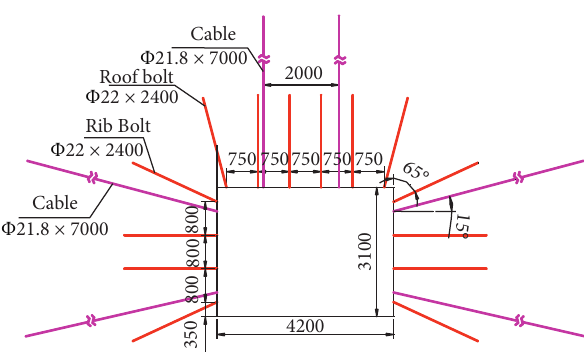
Figure 14: Schematic diagram of optimization scheme (unit: mm).